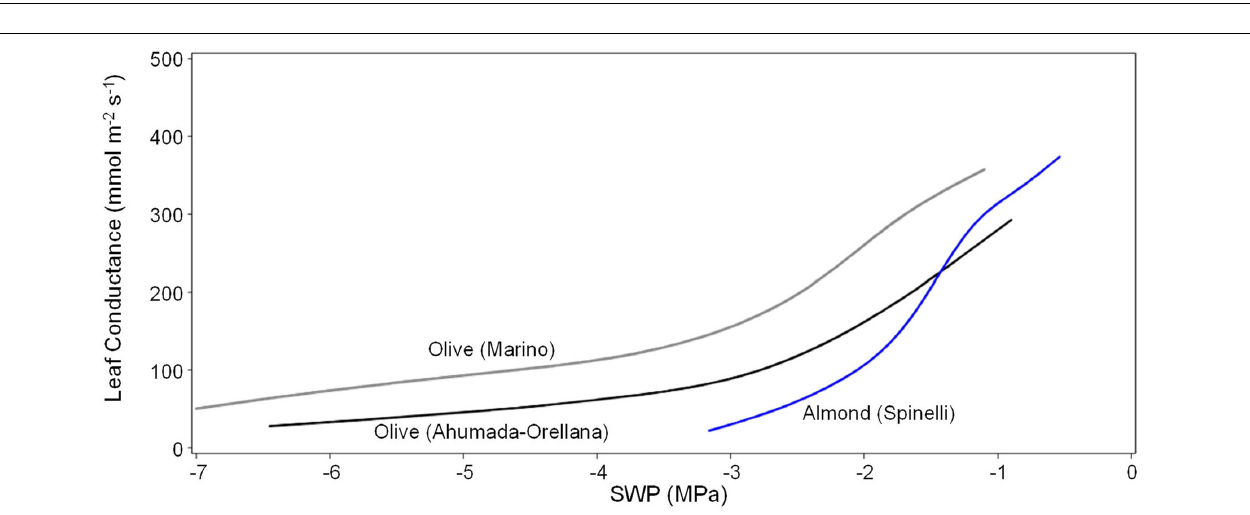
FIGURE 6 | Pooled relation of SWP to midday VPD for all countries, as in Figure 2 , showing the combined linear/exponential relation for the SHD data of García-Tejera et al. (2021, dashed line), as well as the points and linear fit for the upper 0.07 fraction found in the current study. Equation for linear fit is SWP = –0.18 × VPD – 0.34.